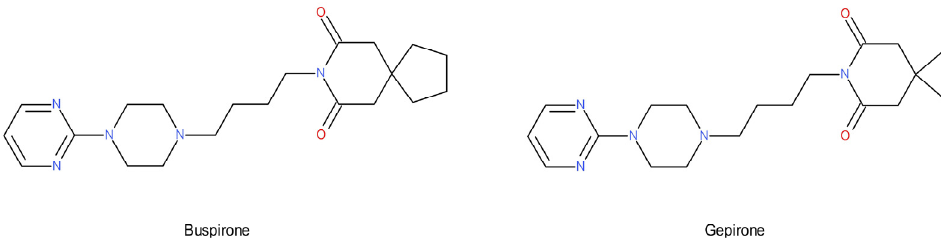
Figure 3. Azapirones: buspirone and gepirone.